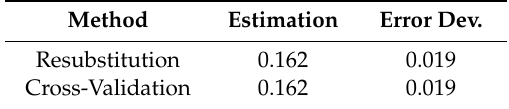
Table 10. Estimation risk for using Twitter (CHAID